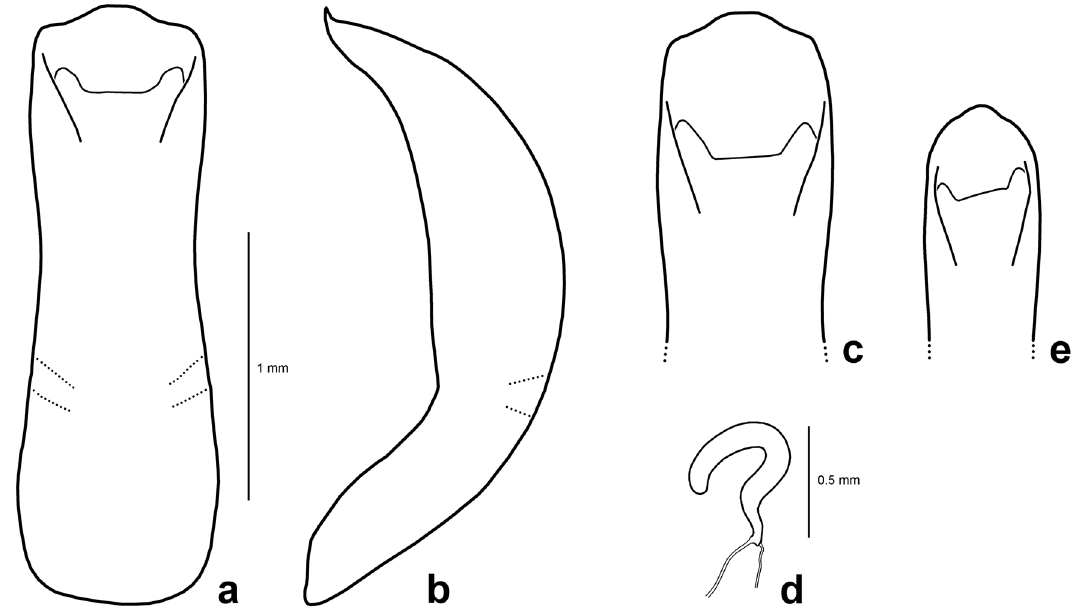
Figure 2. Genitalia of Suinzona borowieci sp. nov. and related species: (a–d) S . borowieci sp. nov. (a) Aedeagus, dorsal view; (b) aedeagus, lateral view; (c) aedeagus, apical view; (d) spermatheca. (e) Aedeagus of Suinzona cyrtonoides , apical view.